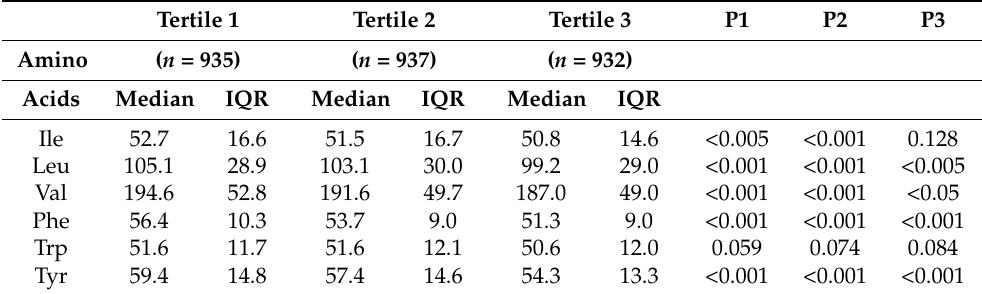
Ile, isoleucine; leu, leucine; val, valine; phe, phenylalanine; trp, tryptophan; tyr, tyrosine. P1 indicates the p -values